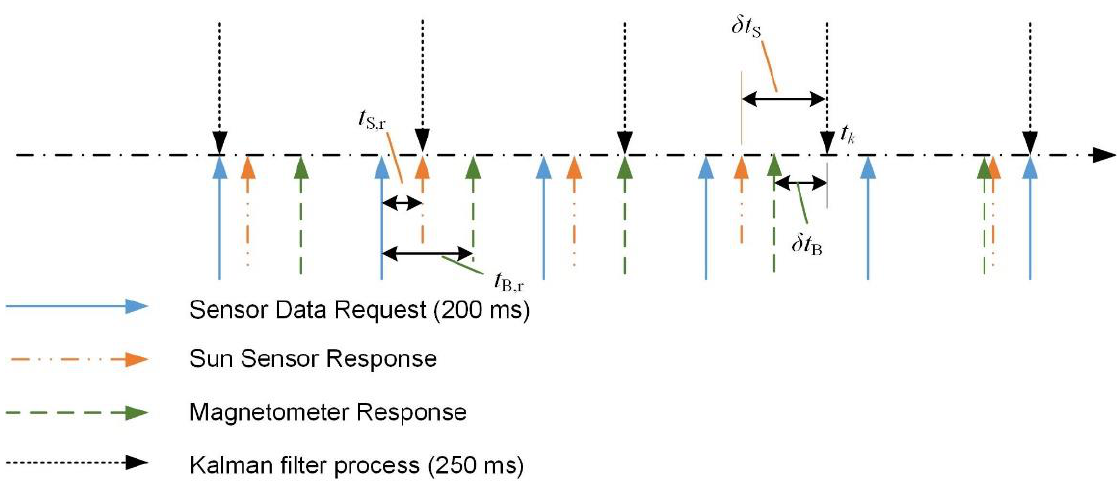
Figure 2. Timestamp of attitude determination task, sensor task, and response of sensor.